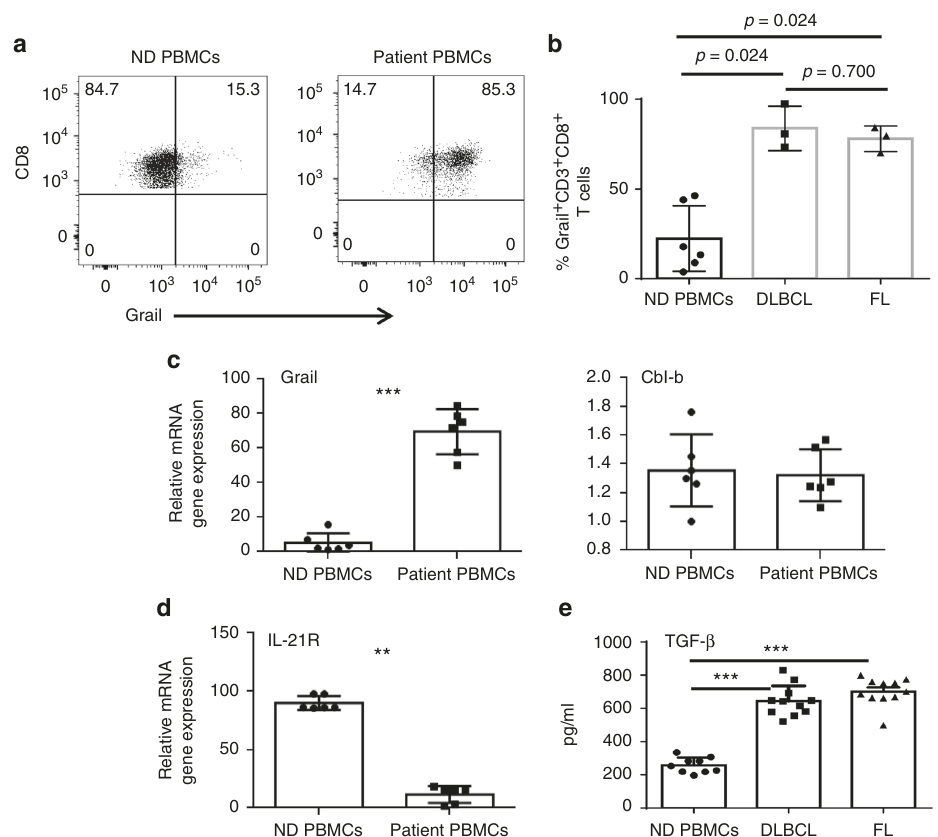
Fig. 7 CD8 + T cells from patients with lymphoma express higher levels of Grail compared to normal donors. a – d PBMCs collected from normal donors (ND) and lymphoma patients ( n = 6 for both groups) were stained with antibodies against CD3, CD8 and Grail. Dead cells were discriminated using AQUA live/dead dye. Gating for Grail was performed using fl uorescence minus one and secondary antibody alone controls. a Grail expression from ND PBMCs ( left ) and patient PBMCs ( right ) is shown. Cells are gated on live, CD3 + CD8 + T cells. b Grail expression in CD3 + CD8 + T cells from normal donors ( n = 6) and lymphoma patients ( n = 3 DLBCL and n = 3 FL). c , d CD3 + CD8 + T cells were FACS-sorted and mRNA expression of Grail, Cbl-b ( c ) and IL-21R ( d ) was detected by RT-PCR analysis. Results for target genes are presented after normalising to β -actin. e Serum from lymphoma patients and normal donors was assessed for levels of TGF- β by ELISA. ( n = 9 normal donors, 11 DLBCL and 11 FL patients). b , e Bar graphs shows mean ± SEM as well as individual patient samples. ** p < 0.01, *** p < 0.001 as determined using a Student ’ s t